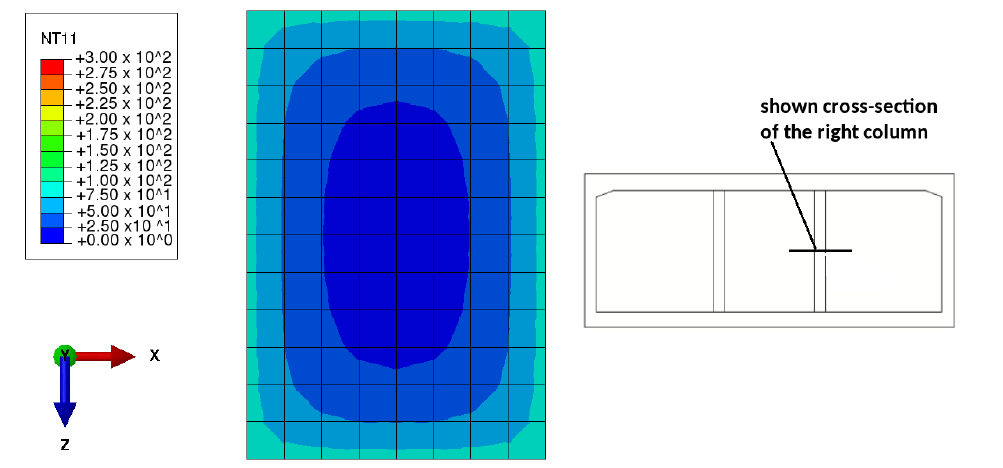
Figure 13. Temperature distribution obtained by prescribing a uniform surface temperature history, 30 min after the start of the thermal loading: detail showing the central cross-section of the right